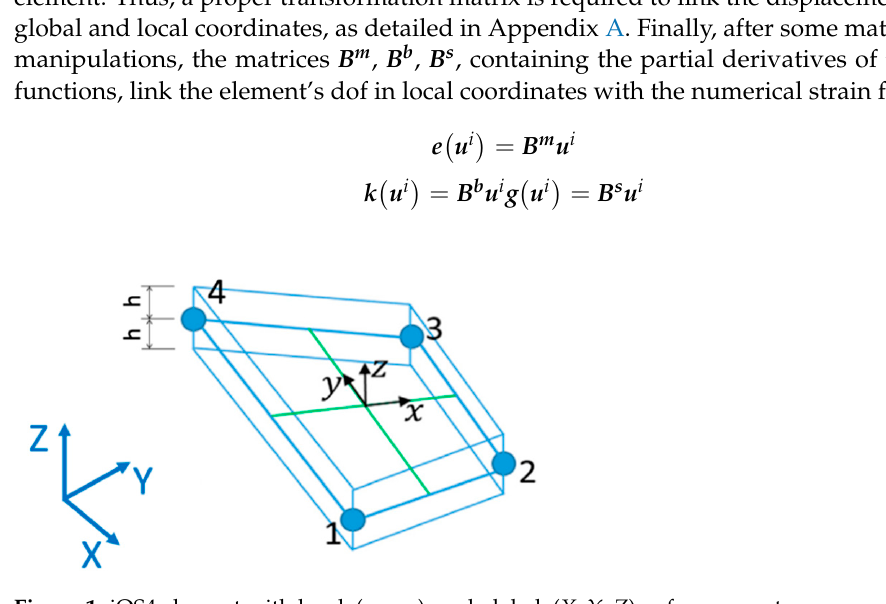
Figure 1. iQS4 element with local, ( x , y , z ), and global, ( X , Y , Z ), reference system. 2.2. Input Strain Formulation